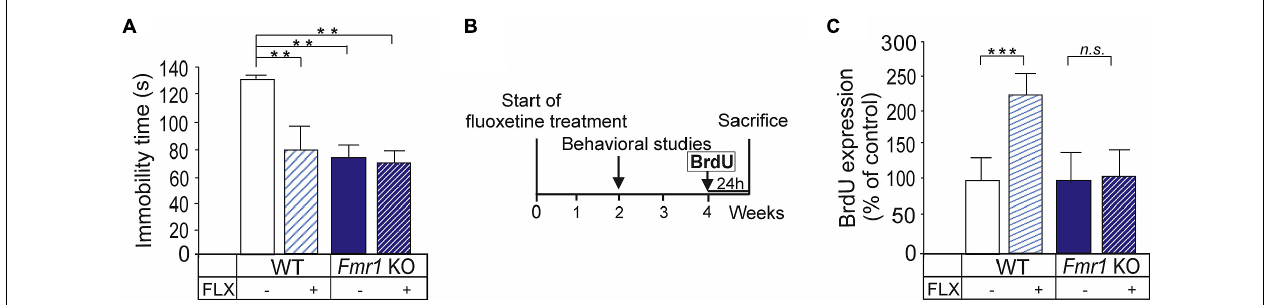
FIGURE 2 |Altered fluoxetine responses on mobility in the forced swim test and proliferation of hippocampal cells. (A) Fmr1 KO mice showed abnormal coping responses under stressful condition in the forced swim test and the immobility time of Fmr1 KO mice was reduced when compared with wild-type controls. Fluoxetine reduced immobility of wild-type mice but not